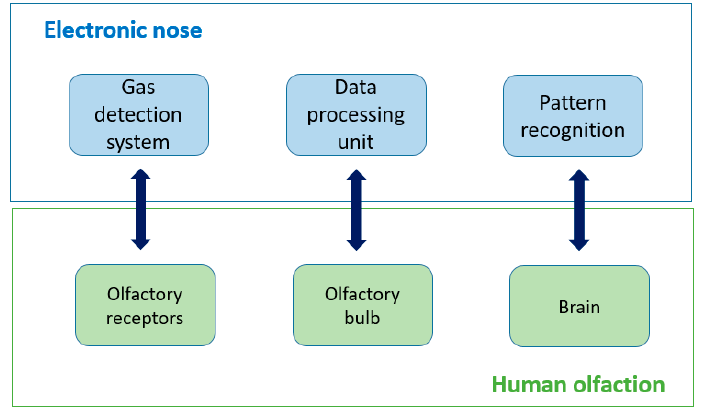
Figure 6. Electronic nose structure .